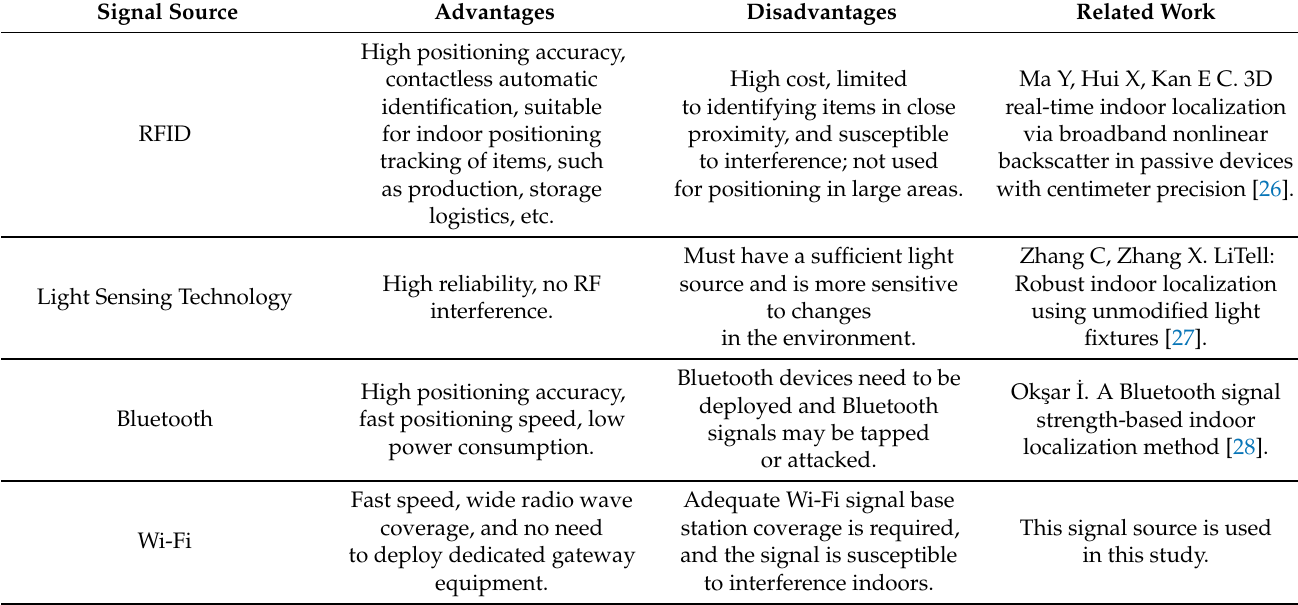
Table 1. Advantages and disadvantages of indoor positioning signal